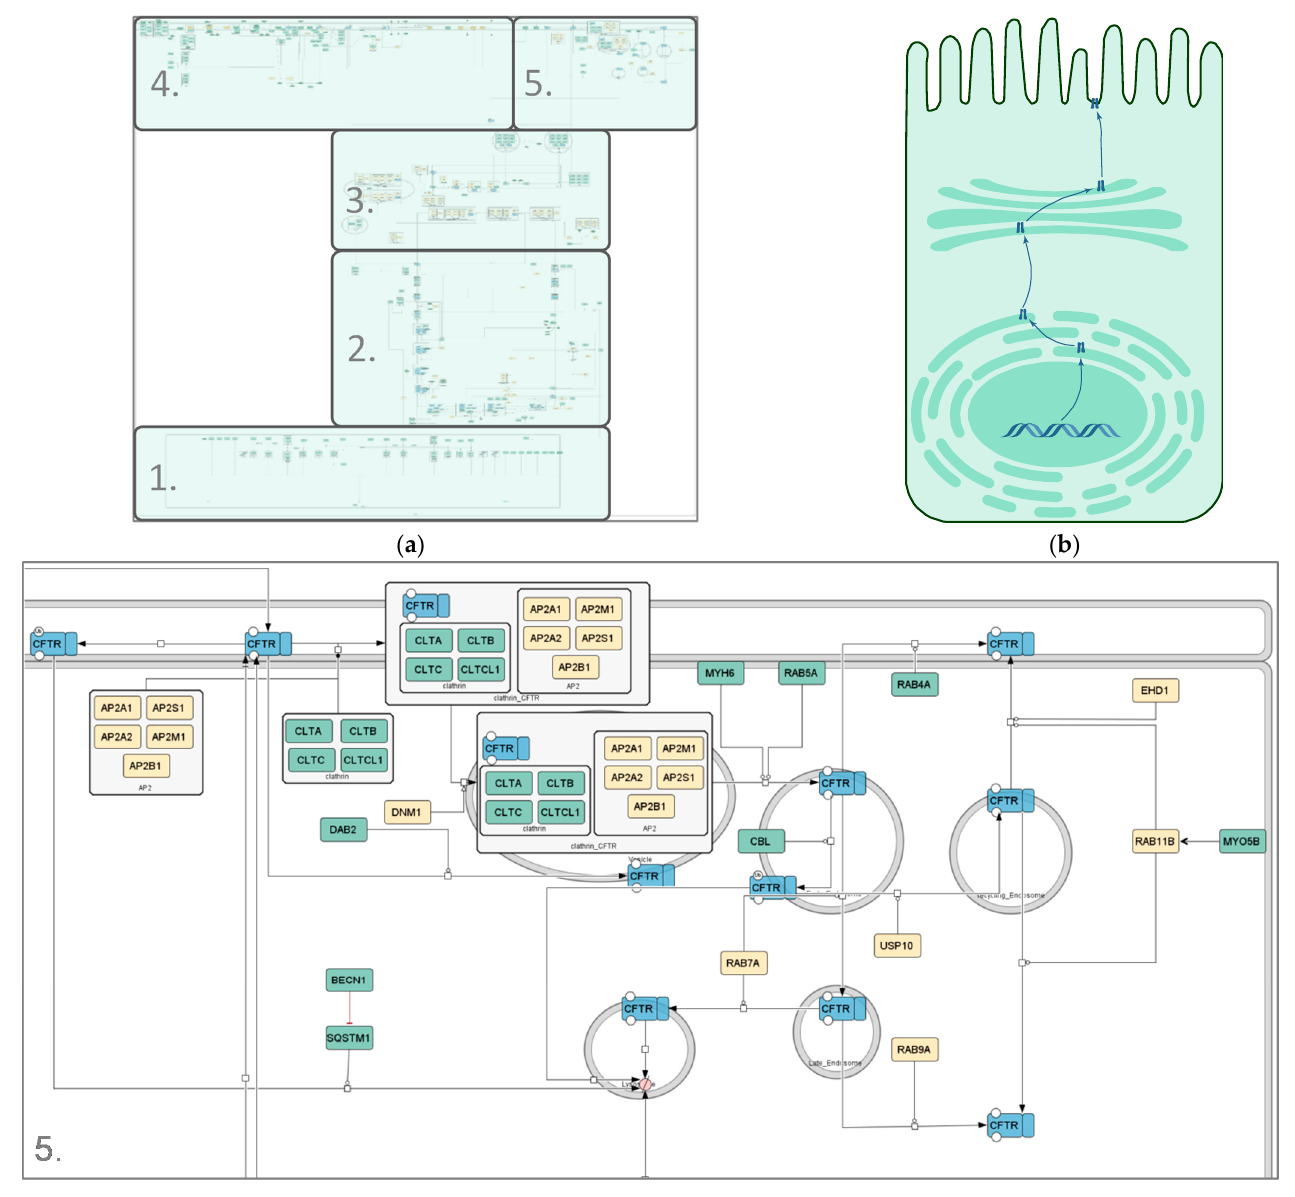
Figure 2. Different representations of the CFTR lifecycle. ( a ) Image of the SBGN-compliant manually curated CFTR lifecycle core map; ( b ) cartoon representation of the CFTR lifecycle in an apical epithelial cell; ( c ) zoomed-in section of the endocytosis pathway in the manually curated CFTR lifecycle core map (submap 5). Compartments are depicted in grey, CFTR in blue and interactors in differing shades of green and yellow. The green color scheme represents interactors identified in at least one polarized cell line; yellow interactors were identified in non-polarized cell lines only. State transitions, catalysis and positive influences are shown in black; negative influences and inhibitions are displayed in red. Different shapes represent different kinds of interactors. Rounded rectangles correspond to proteins, ovals and circles to small molecules and ions, respectively, rectangles correspond to genes, rhomboids to RNA molecules and chevron shapes to receptors. The map was created using CellDesigner4.4.2.